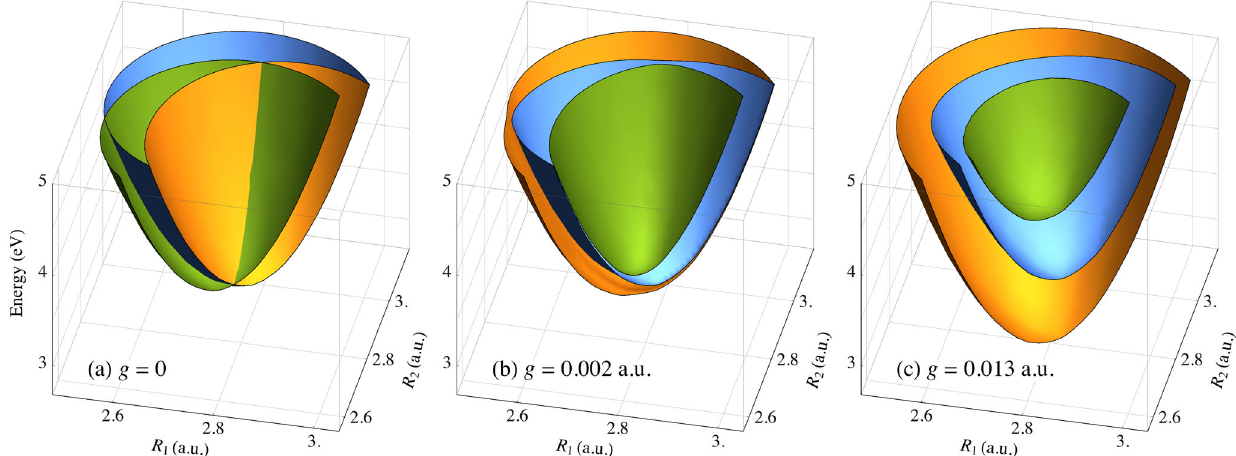
R 1 ; R 2 Þ eg 0 ð